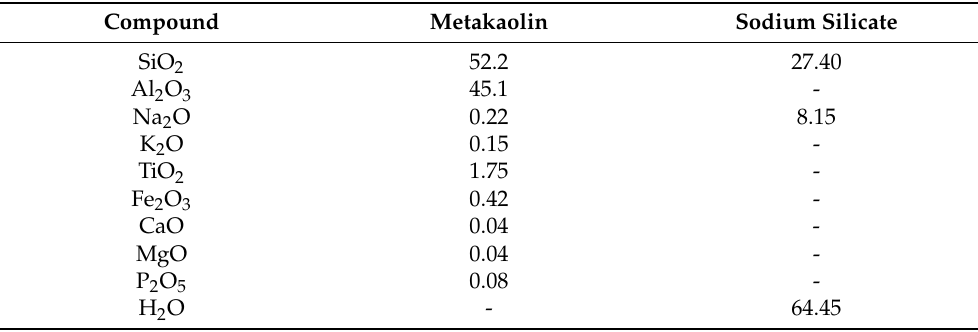
Table 1. Chemical composition (weight %) of the metakaolin BASF MetaMax ® and sodium silicate solution used in this paper.